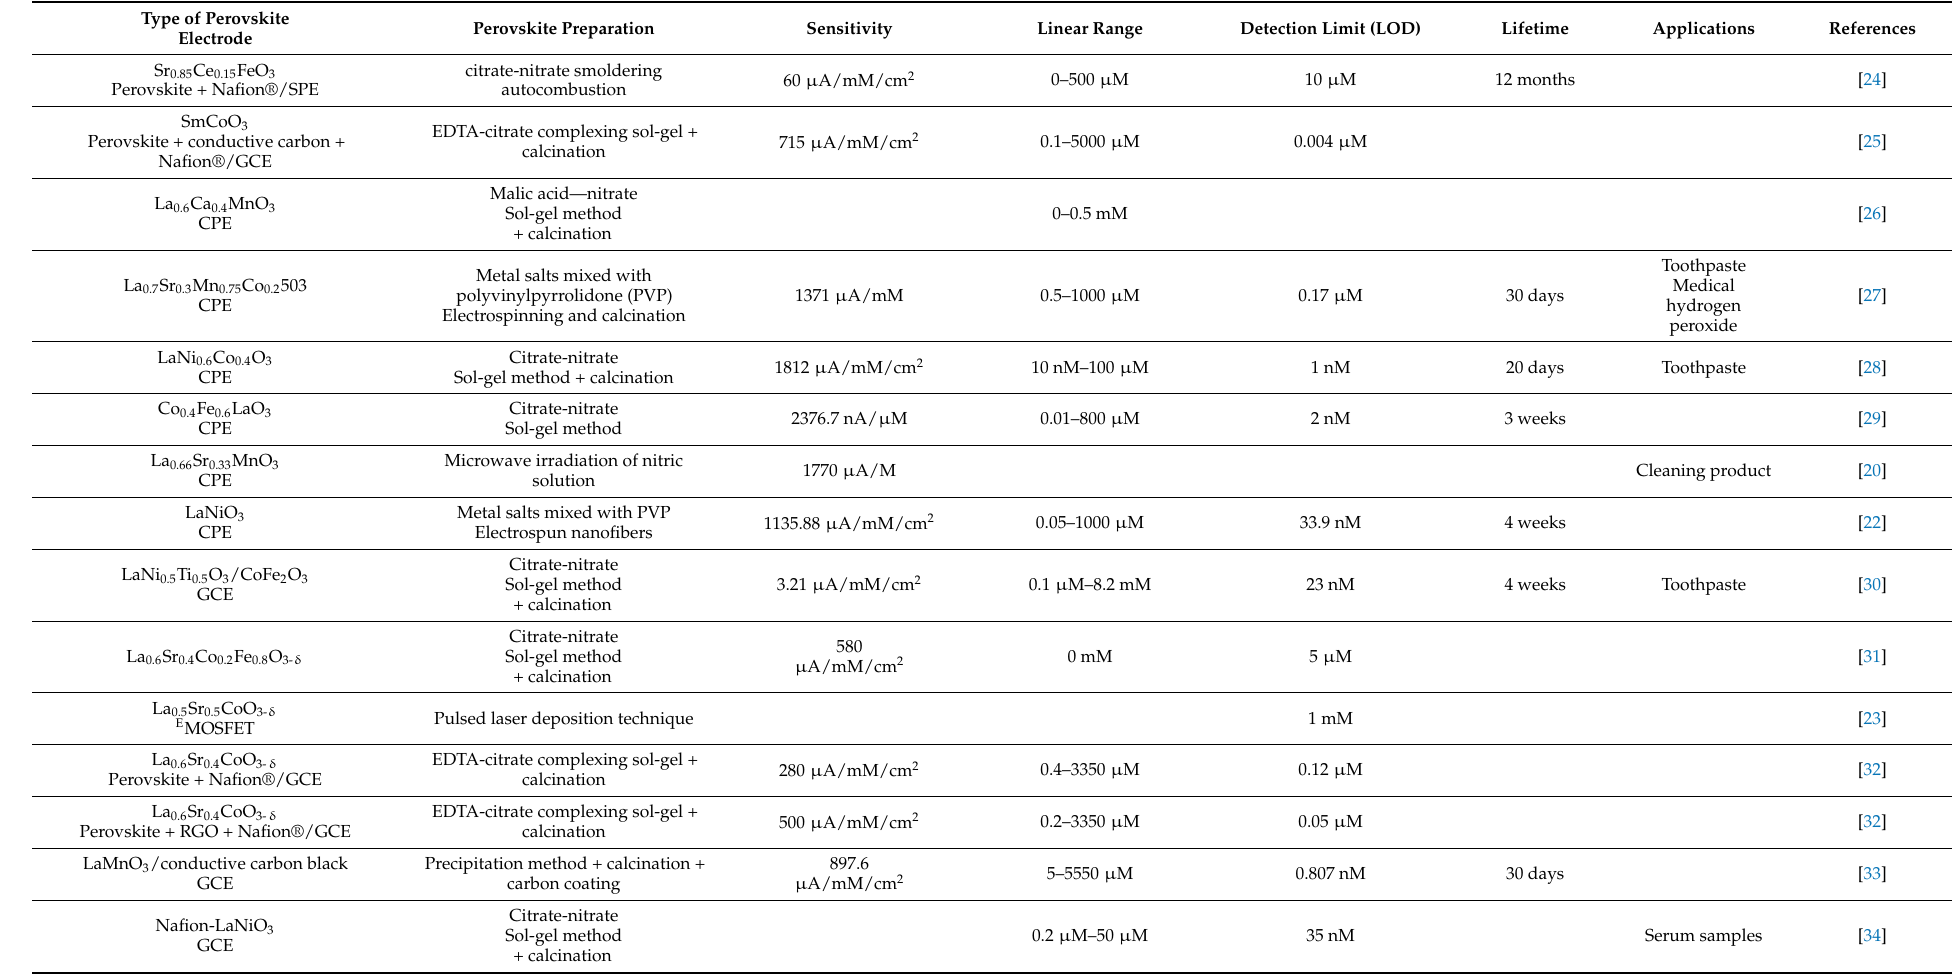
Table 1. Perovskite-based electrochemical sensors for the detection of hydrogen